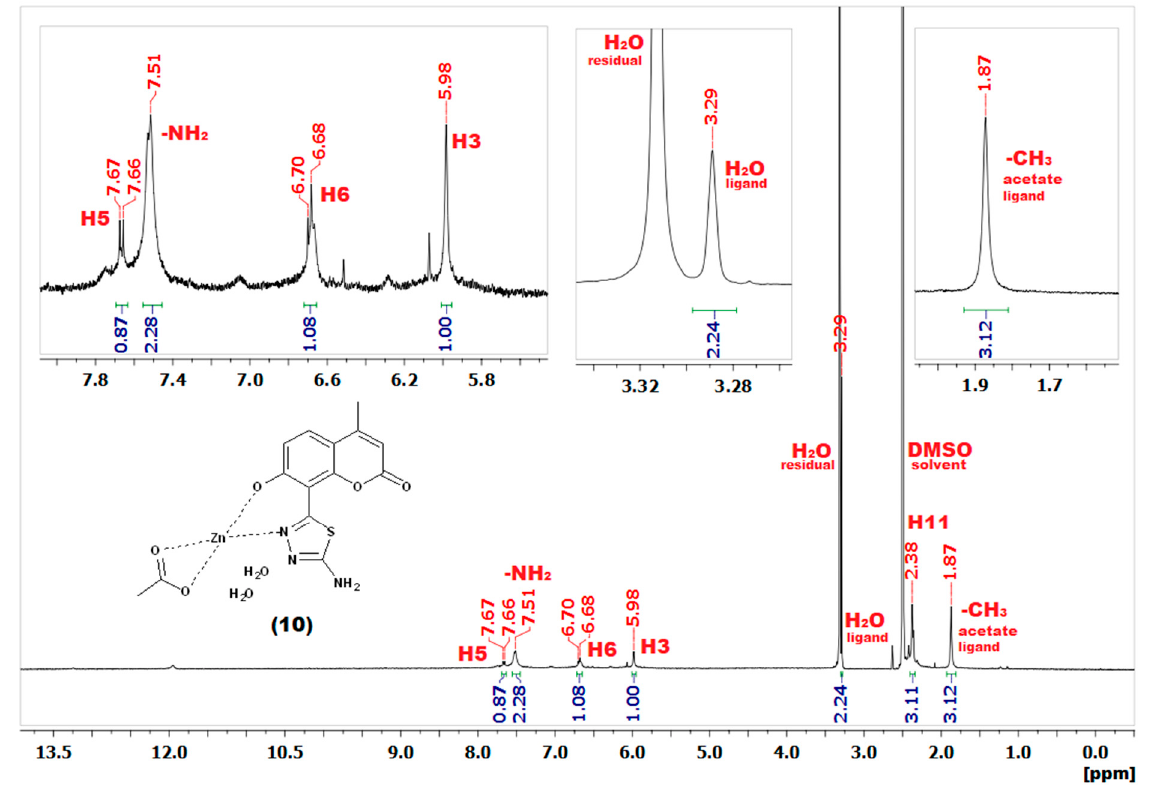
Figure 7. 1 H-NMR (DMSO-d 6 ) spectrum of Zn(II) complex 10 with expansions showing signals originating from the aqueous and acetate ligands.